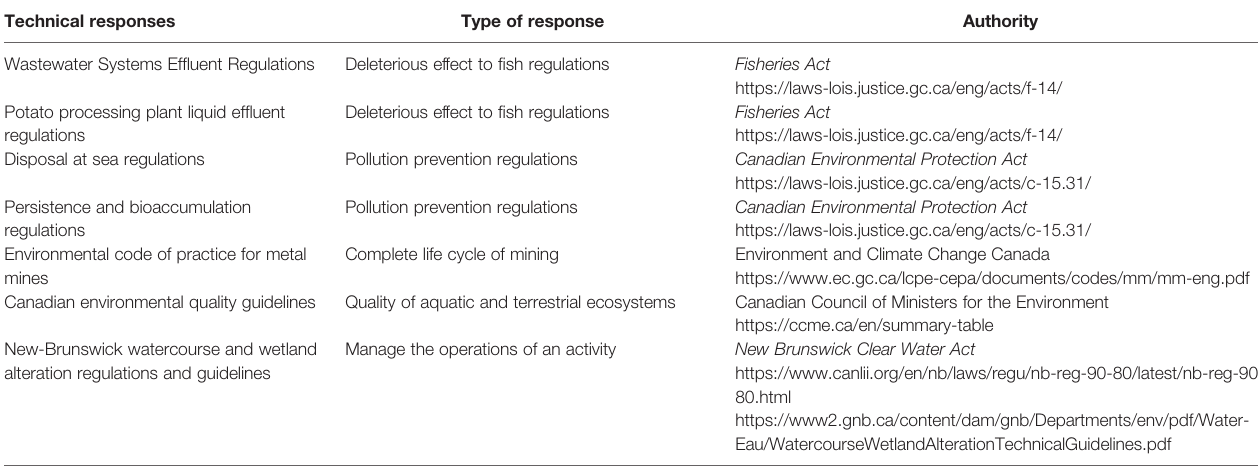
TABLE 2 | Examples of regulations, codes of practice, and guidelines as technical